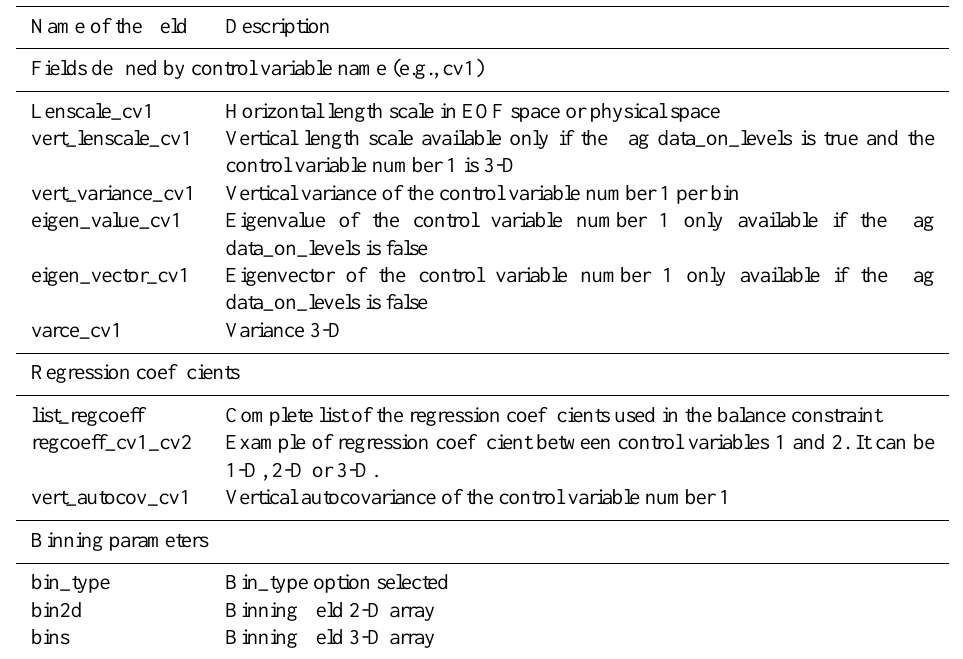
Table A3. Content of the final output file be.nc (NetCDF format) of the GEN_BE v2.0 code. Name of the